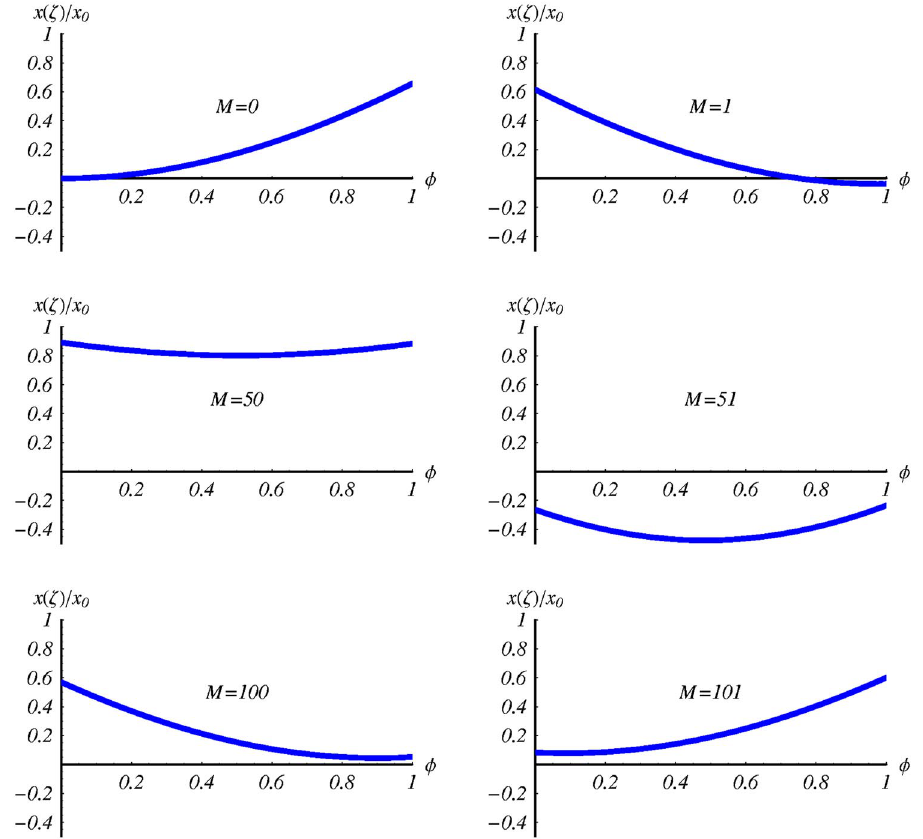
FIG. 9. (Color) Bunch shapes in a train of finite-length bunches. The parameters are the same as in Fig.